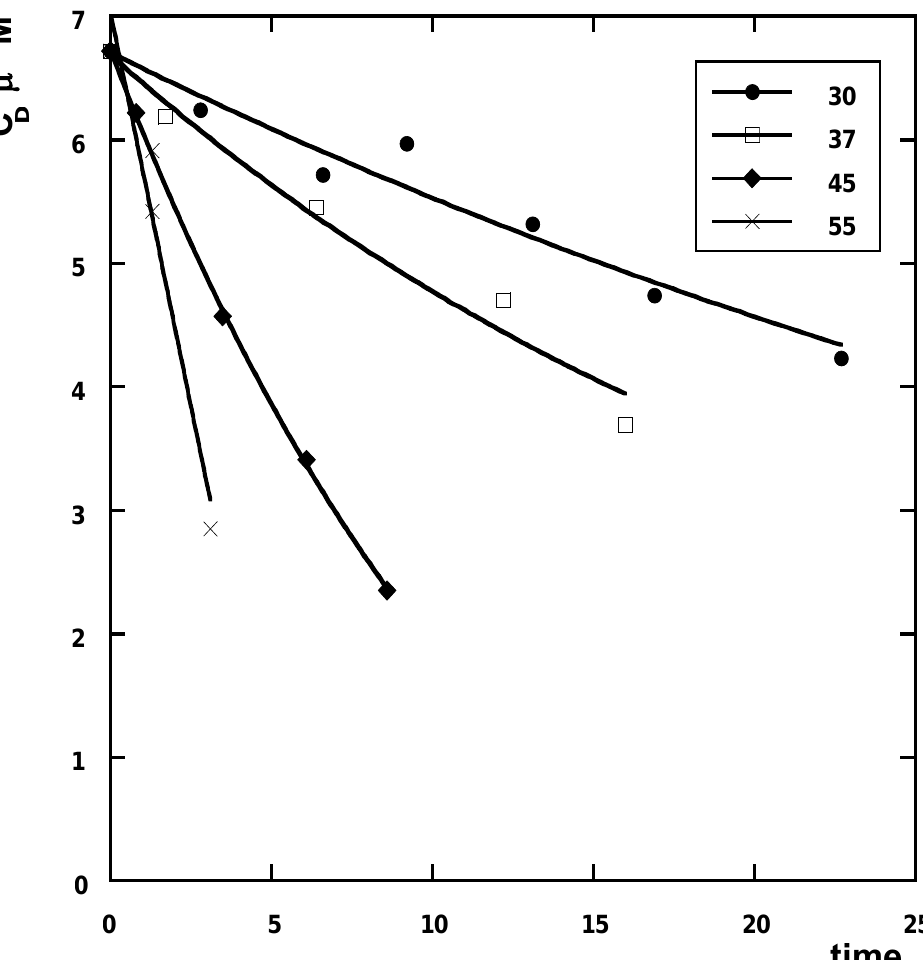
Figure 12. Diuron degradation kinetics profiles in the co-presence of PDS and MnO 2 at different temperatures, modeled by using Equation (15).